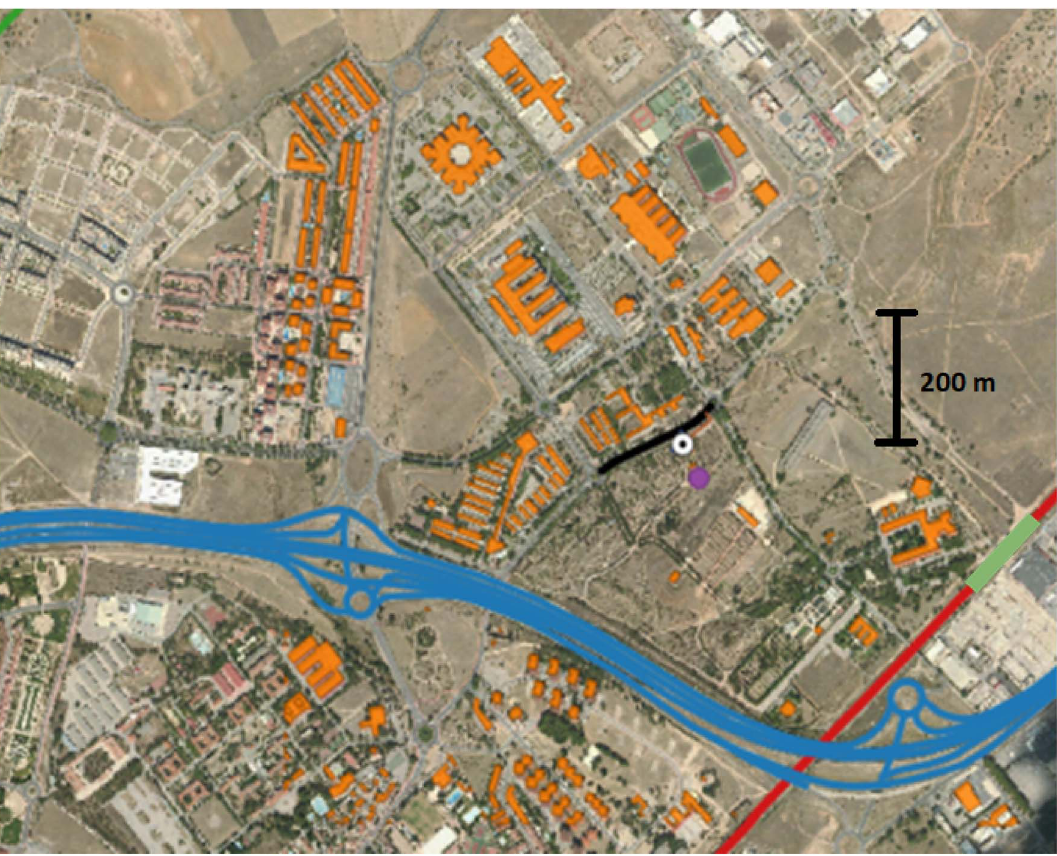
Fig. 4. Map showing the environment surrounding the station. The black dot inside a small white circle shows the location of the magnetometer test recordings. The Madrid-Barcelona highway is shown in blue, railways are marked in red and close buildings are colored in